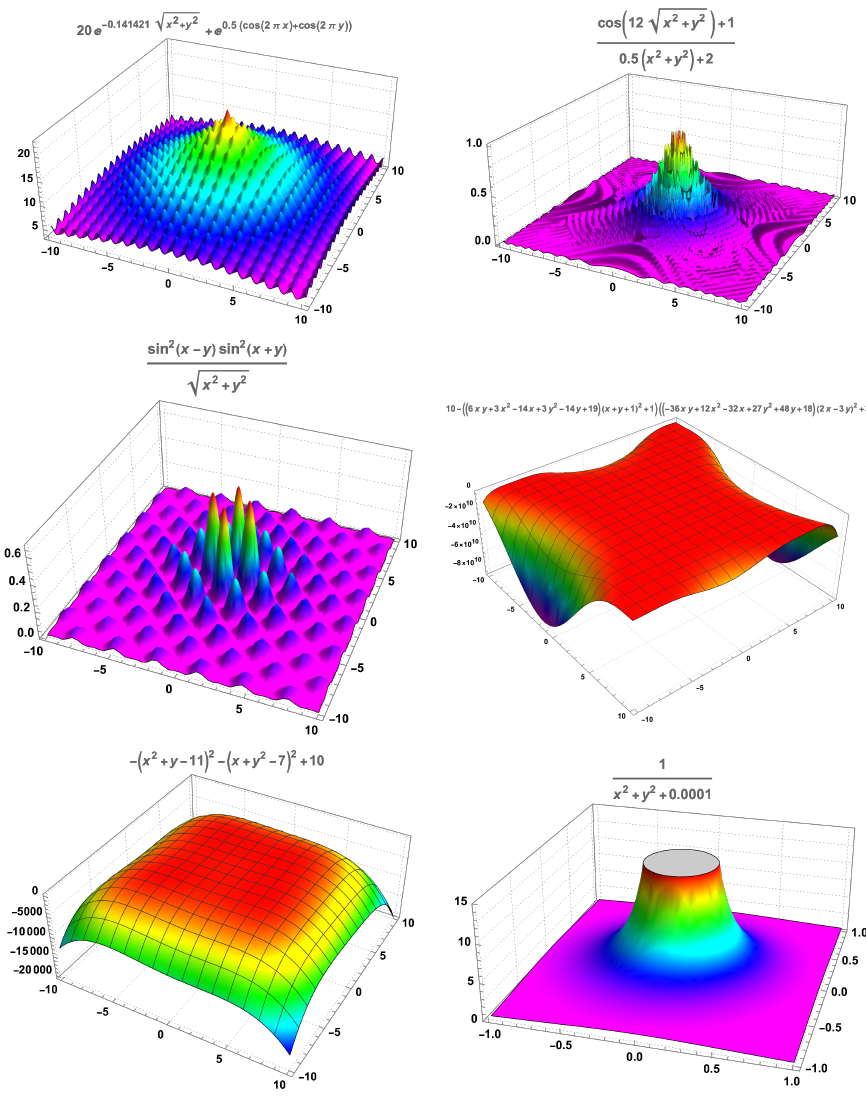
Figure A1. Test functions, from left to right and top to down: Ackley’s, drop-wave, Keane’s, Goldstein-Price’s, Himmelblau’s and nearly unbounded .